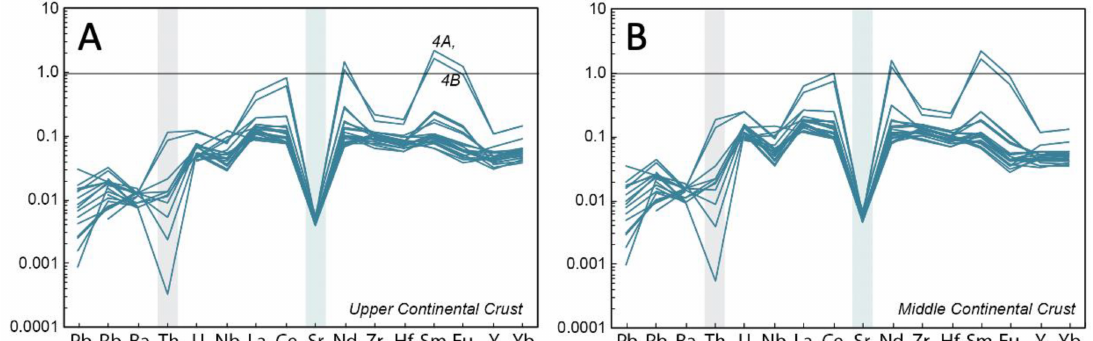
Figure 6. Geochemical trends observed in sampled Kinnikinic Quartzite. Samples 4A and 4B are consistently chemically anomalous compared to the remaining sample set. With respect to the compositional parameters shown above samples 4A and 4B are consistent enriched (panels A–C). For discussion see main text. ( A ) Al 2 O 3 wt. % positively correlates with Rb (ppm), ( B ) K 2 O wt. % positively correlates with Rb (ppm), ( C ) Zr (ppm) positively correlates with Hf (ppm), ( D ) weakly positive correlation between Fe 2 O 3 (wt. %) and Au (ppm).